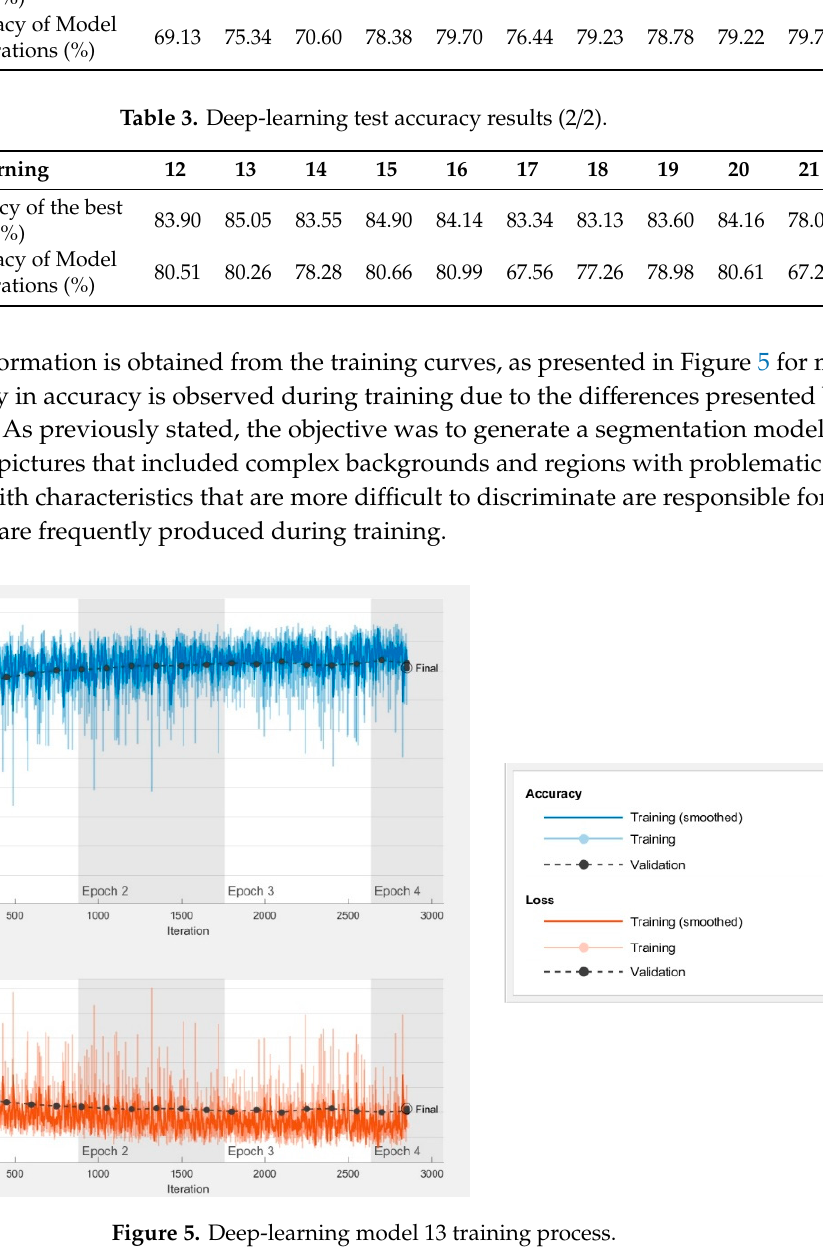
Figure 5. Deep-learning model 13 training process.